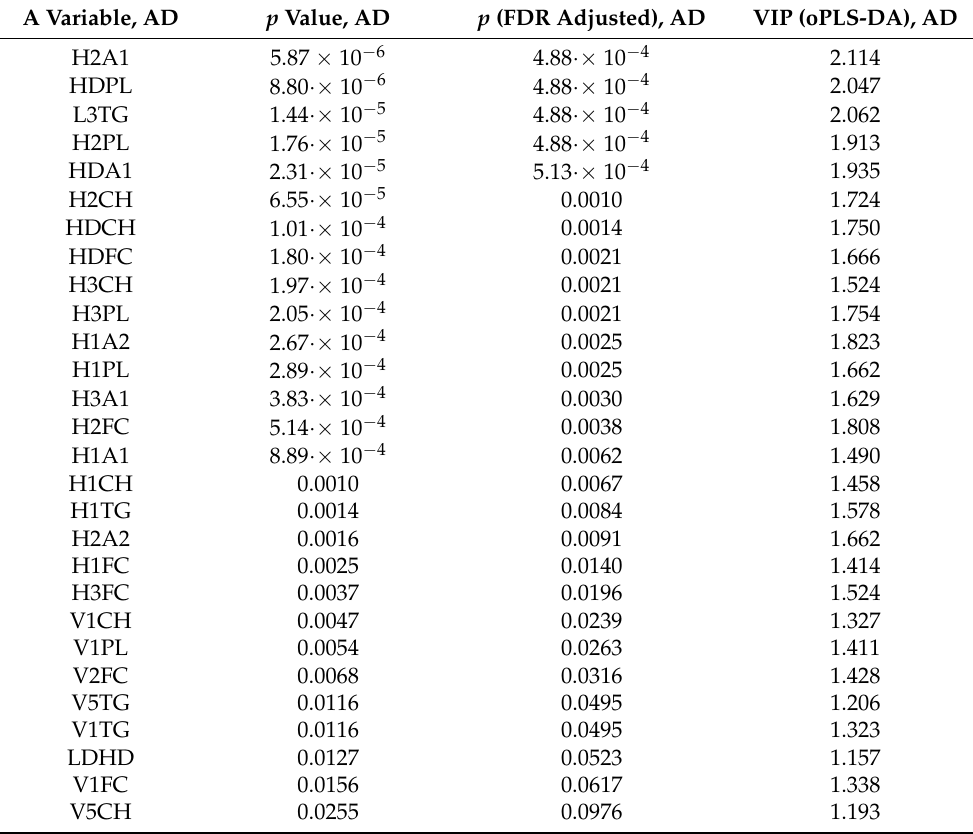
Table A1. Volcano plot (FC > 1.20, p < 0.1) variables including false discovery rates (FDR) adjusted p -values and regression analysis VIP scores based on the male-female comparison of only AD patients (A), only Controls (B) and only MCI (C)